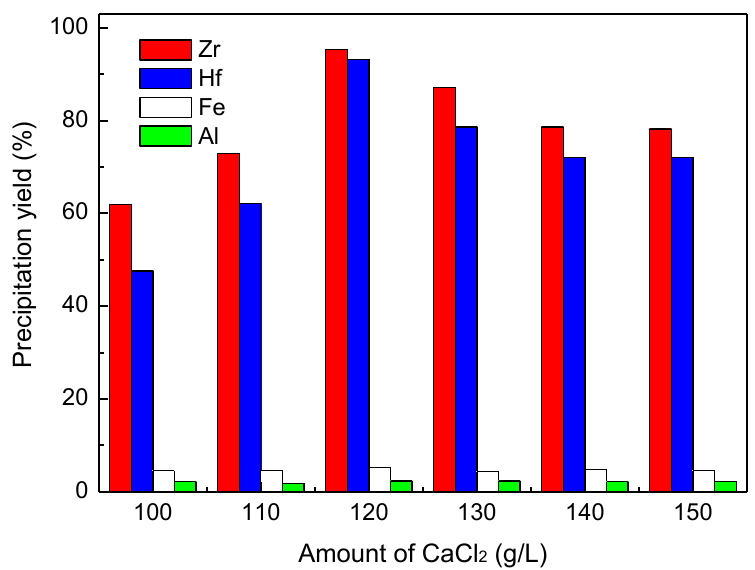
Figure 6. Effect of CaCl 2 quantity on the Zr precipitation yield, Zr precipitation conditions: 75 °C, final pH ~1.6, 60 min.